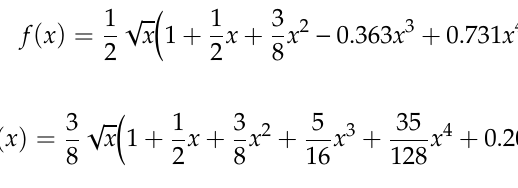
Figure 4. A loading cycle applied under the condition of Δ K III / Δ K I = 1.0 and δ = 30°.